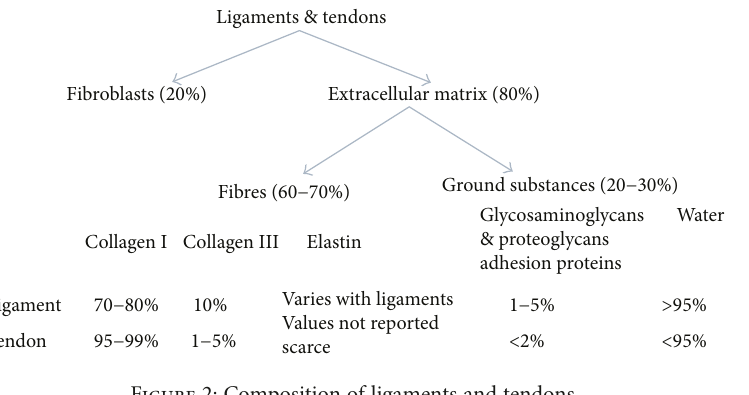
Figure 2: Composition of ligaments and tendons.